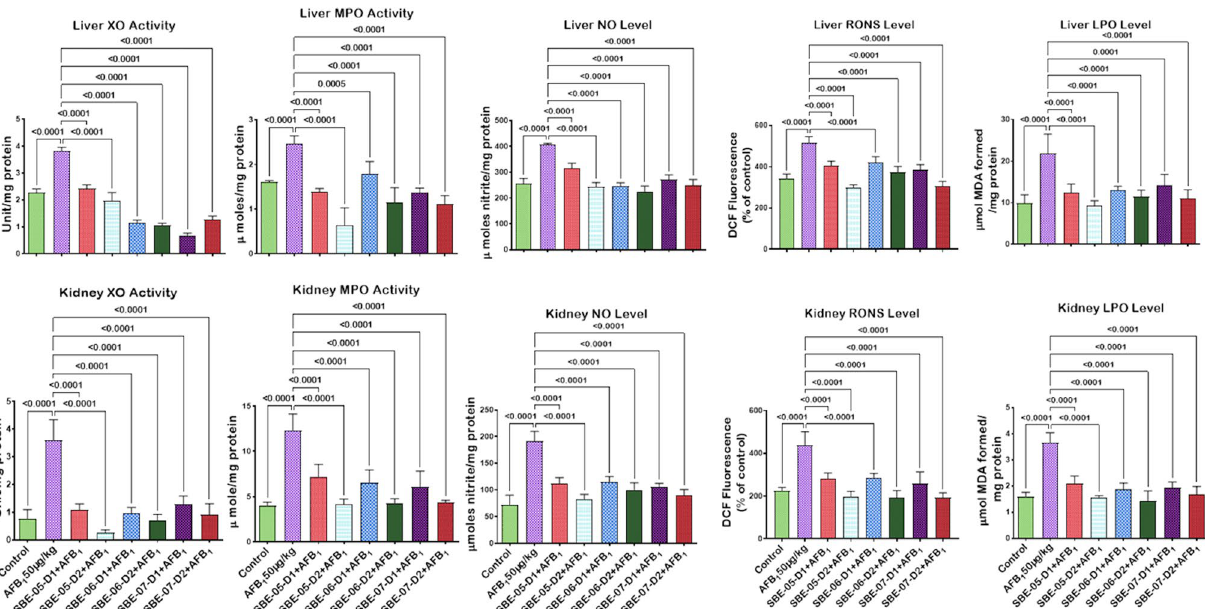
Figure 7. Effect of SBE-05, SBE-06 and SBE-07 on the level XO, LP, RONS, NO, and MPO in the liver and kidney of rats treated with AFB 1 for 28 d. Experimental doses: AFB 1 at 50 μg/kg; SBE-05-D1 at 5 mg/kg; SBE-05-D2 at 10 mg/kg; SBE-06-D1 at 5 mg/kg; SBE-06-D2 at 10 mg/kg; SBE-07-D1 at 5 mg/kg; SBE-07-D2 at 10 mg/kg. Values are expressed as mean ± SD for 6 rats per treatment cohorts. Connecting lines indicate groups compared to one another, the significance level was set at (p < 0.05) ; * p < 0.05; ** p < 0.01; *** p < 0.001; **** p < 0.0001: indicates the level of significance; p > 0.05: not significant. AFB 1 Aflatoxin B1; D1 lower dose; D2 higher dose; XO Xanthine oxidase; LPO Lipid peroxidation; RONS Reactive oxygen and nitrogen species; NO Nitric oxide; MPO